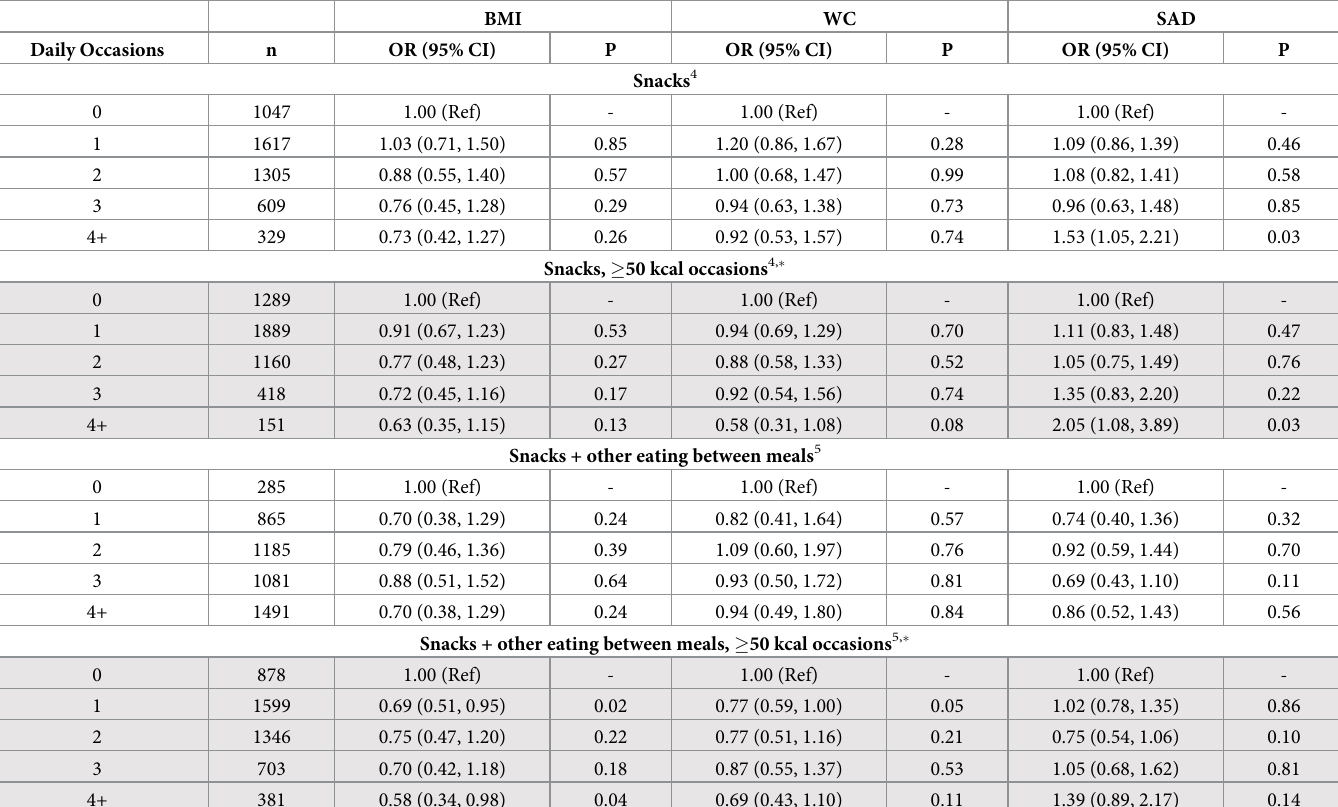
Table 5. Odds ratio of overweight or obesity (BMI � 25 kg/m 2 ), Waist Circumference (WC) > 102cm, and Sagittal Abdominal Diameter (SAD) > 25cm with snack- ing frequency among U.S. adult women ( � 20y), NHANES 2013–2016 1-3